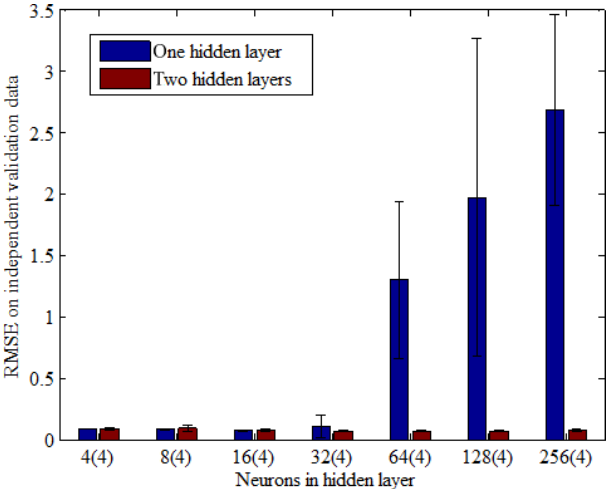
Figure 4. Comparison of the performance of one hidden layer vs. two hidden layers in predicting independent validation data. The number of neurons in the first hidden layer was the same in the one- hidden-layer as in the two-hidden-layer model; numbers in paren- theses show the number of neurons in the second hidden layer (for the two-hidden-layer model). Bars show the mean and standard de- viation of the root mean square error over a 10-fold cross-validation, for different numbers of neurons in the first hidden